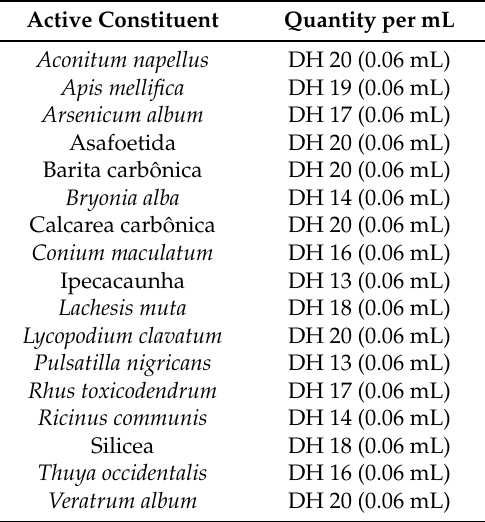
Table 4. Composition of Canova ®